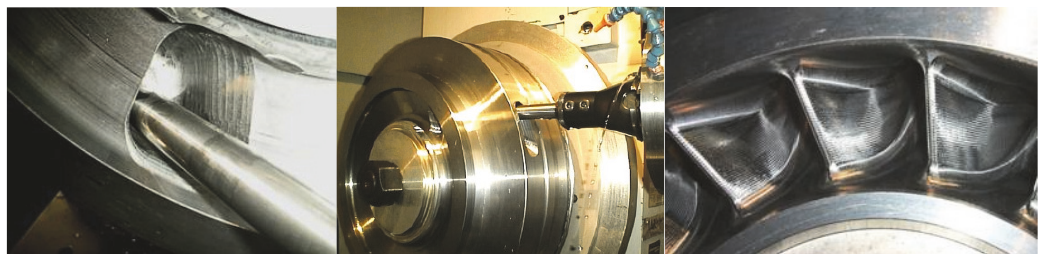
Figure 1: Some examples of impeller milling processes.